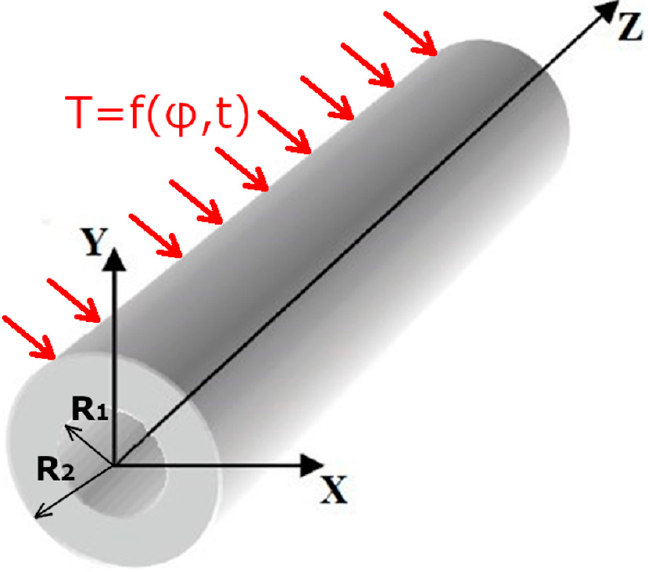
Figure 2. Model of the Earth as an infinite hollow cylinder, the so-called ‘Earthcylinder’ with heating from the Sun (not to scale).